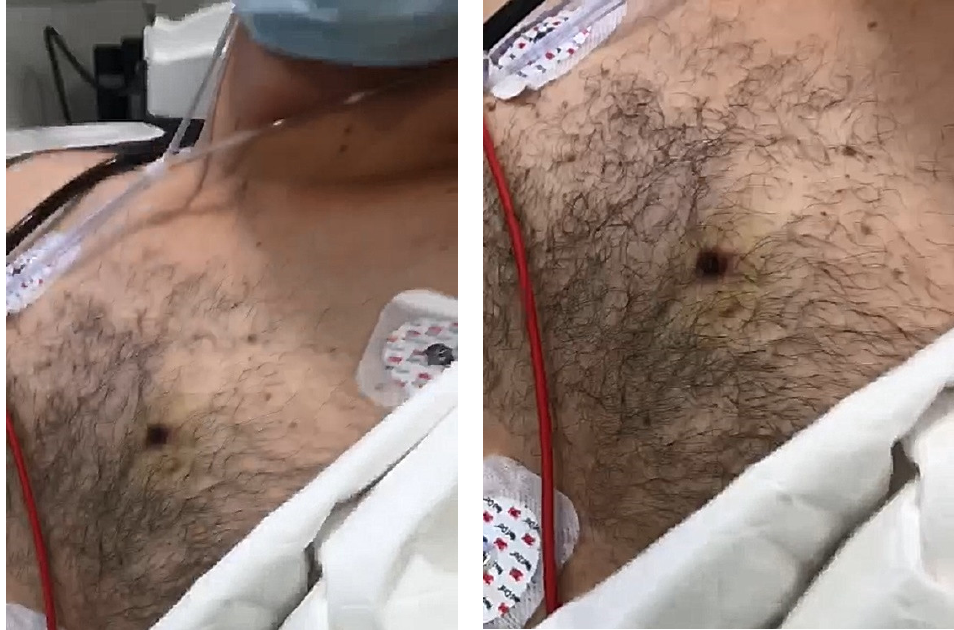
Figure 2. Puncture wound with hematoma at the 4th intercostal space of the left hemithorax. During the first examination in the emergency room the wound was hidden behind an ECG sticker.